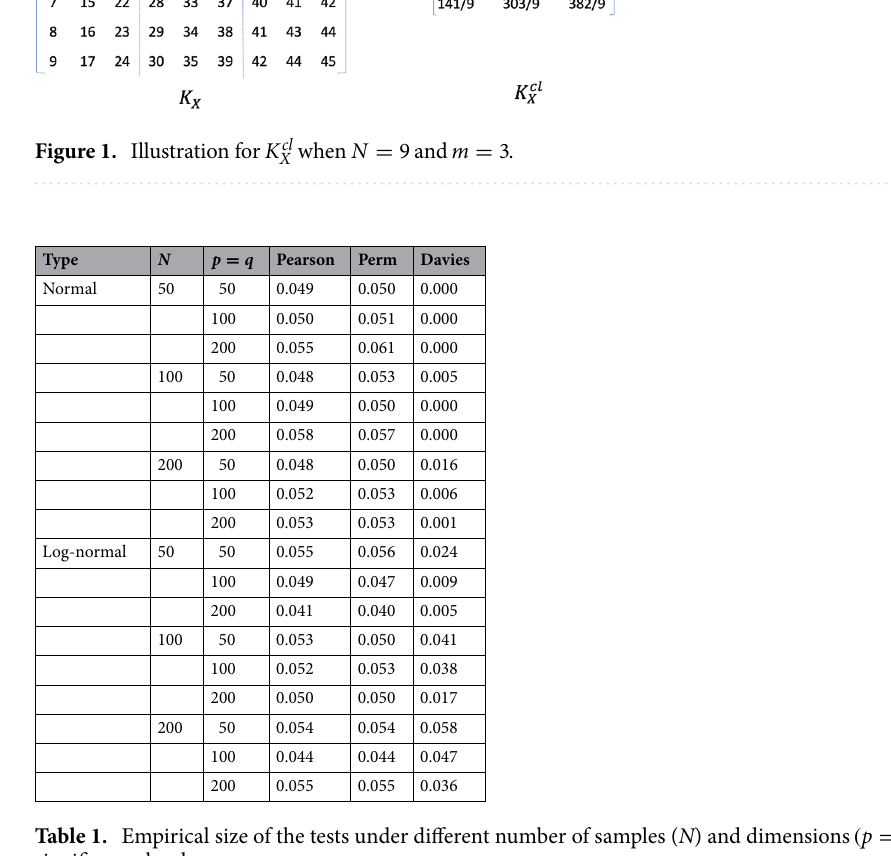
Table 1. Empirical size of the tests under different number of samples ( N ) and dimensions ( p = q ) at 0.05 significance